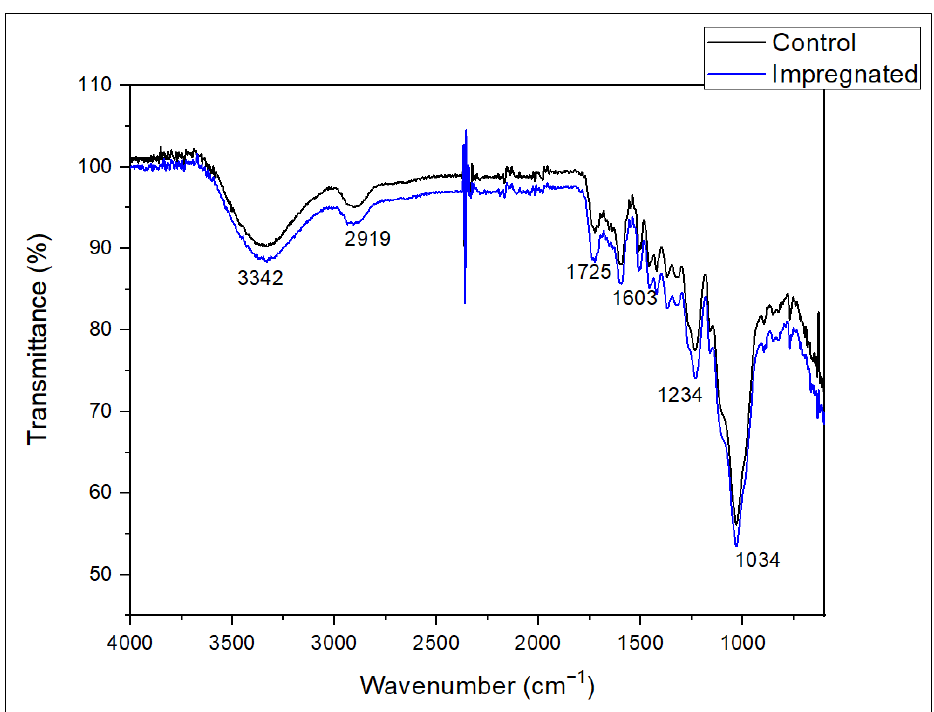
Figure 7. FTIR spectra of control and impregnated coconut shell samples.